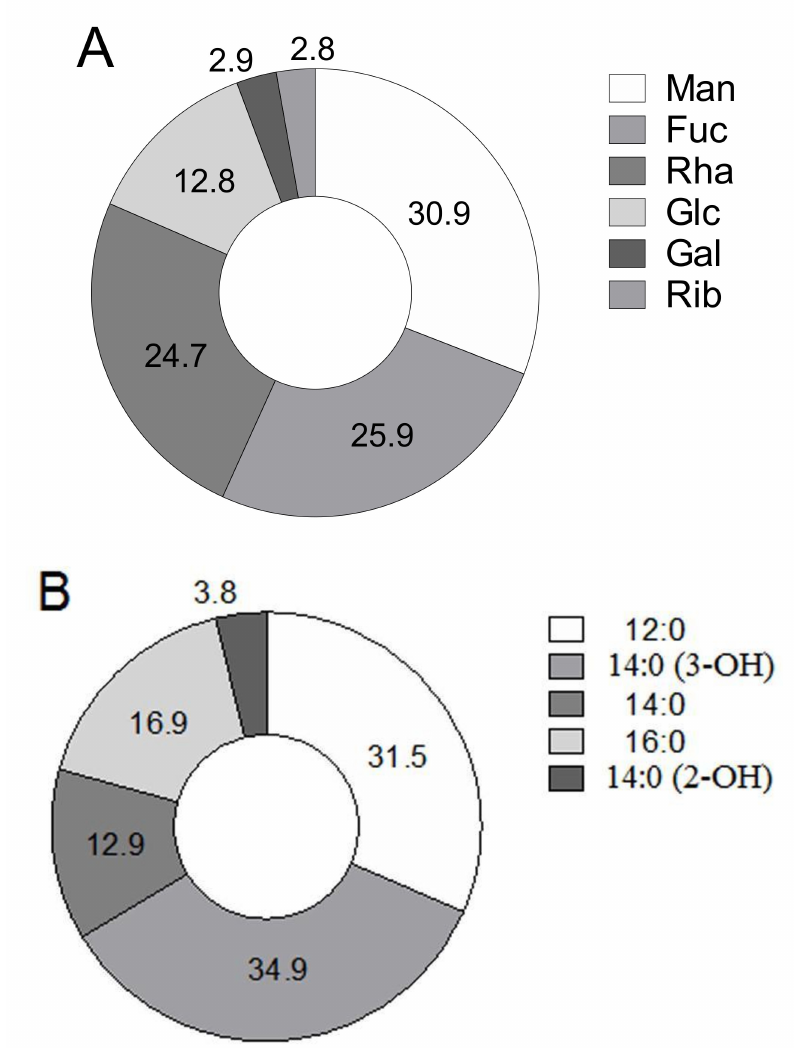
Figure 1. The monosaccharide ( A ) and fatty acid ( B ) compositions of P. agglomerans 8488 LPS. The monosaccharide and fatty acid compositions of LPS were expressed in percentage to the total sum of peak areas. Man = mannose, Fuc = fucose, Rha = rhamnose, Glc = glucose, Gal = galactose, Rib = ribose; 14:0 (3–OH)-3-hydroxytetradecanoic acid, 12:0—dodecanoic acid, 14:0—tetradecanoic acid, 16:0—hexadecanoic acid, 14:0 (2–OH)-2-hydroxytetradecanoic